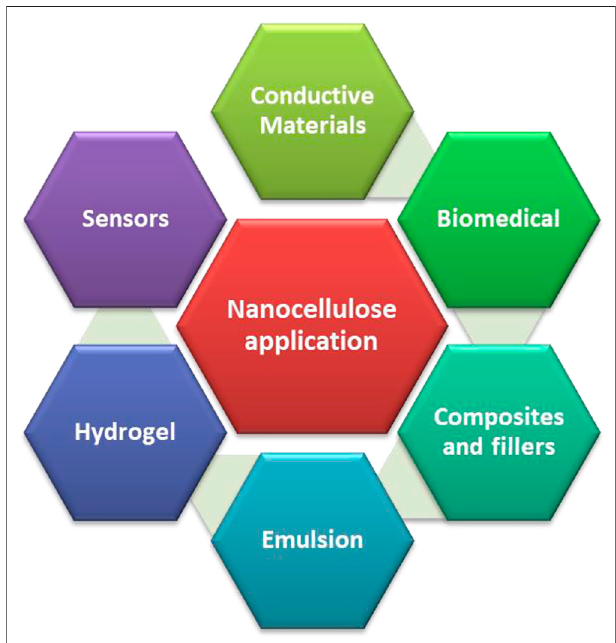
FIGURE 6 | Application of nanocelluloses in various fi